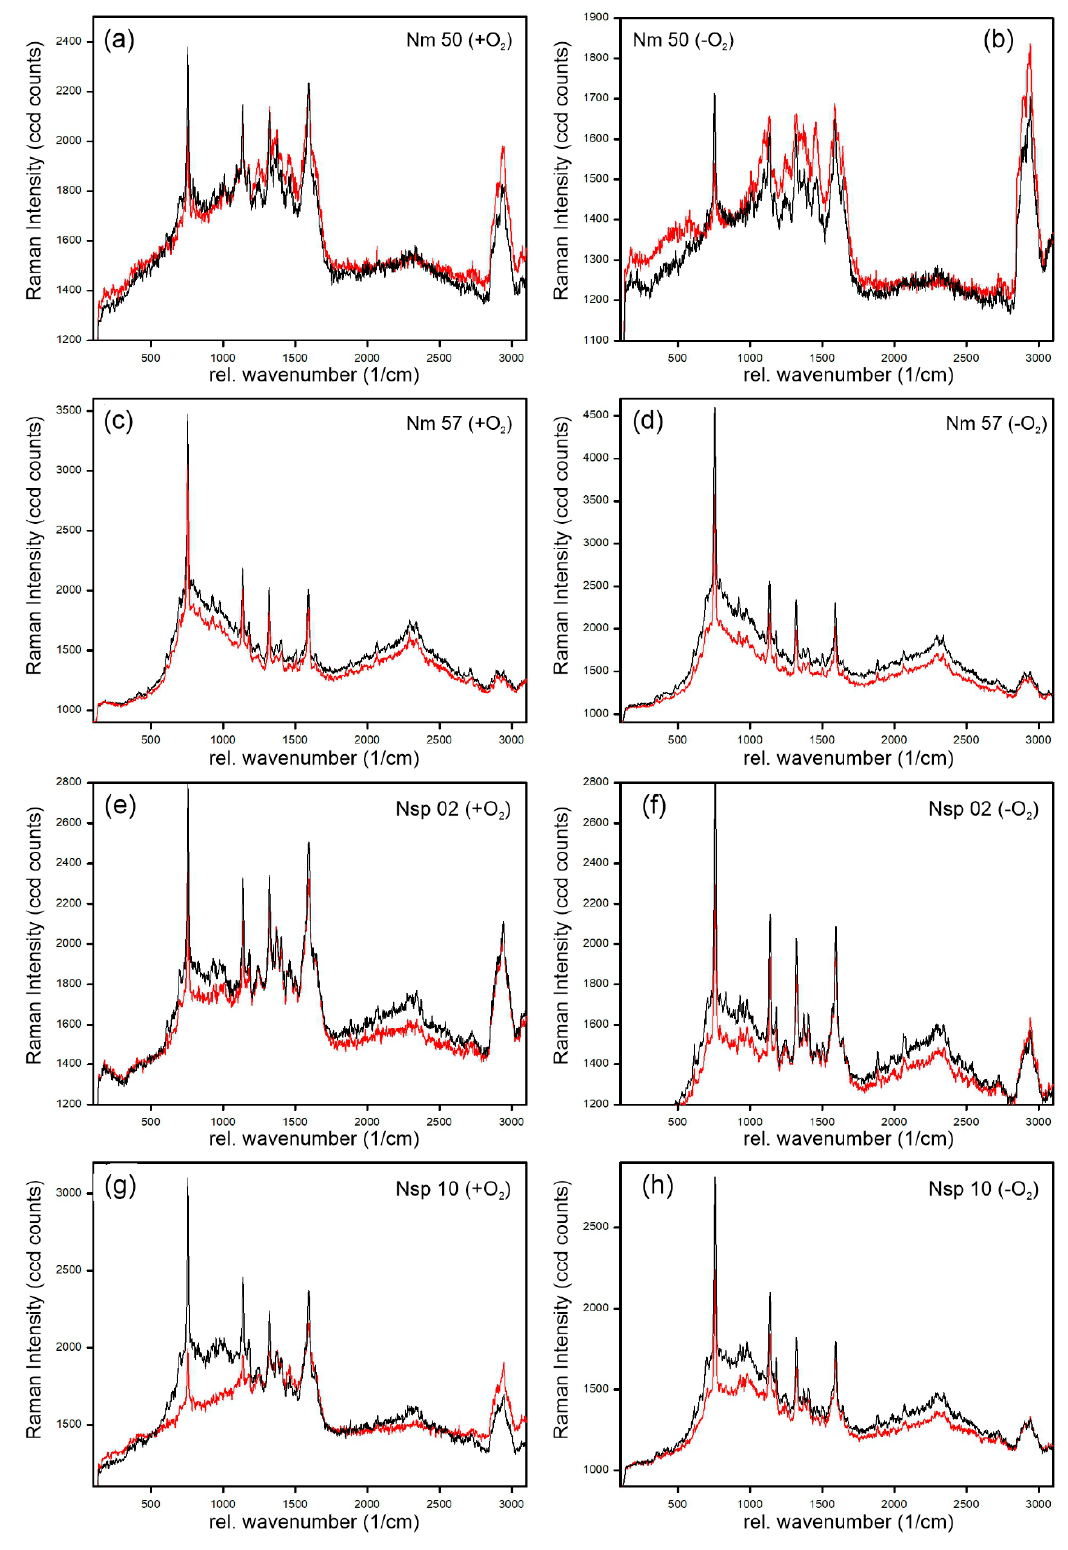
Figure 1. Cytochrome-c-resonant Raman spectra of Nitrosomonas europaea (Nm 50) ( a , b ), Nitrosomonas eutropha (Nm 57) ( c , d ), Nitrosospira sp. (Nsp 02) ( e , f ), and Nitrosospira briensis (Nsp 10) ( g , h ) as recorded in vivo from individual bacteria cells in well-aerated ( a , c , e , g ) and oxygen-deprived ( b , d , f , h ) cultures. Black spectra represent a maximal relRI (most ferrous cytochrome c content of the cell), and red spectra a minimal relRI (least ferrous) for the respective culture. Please note the different intensity ranges.